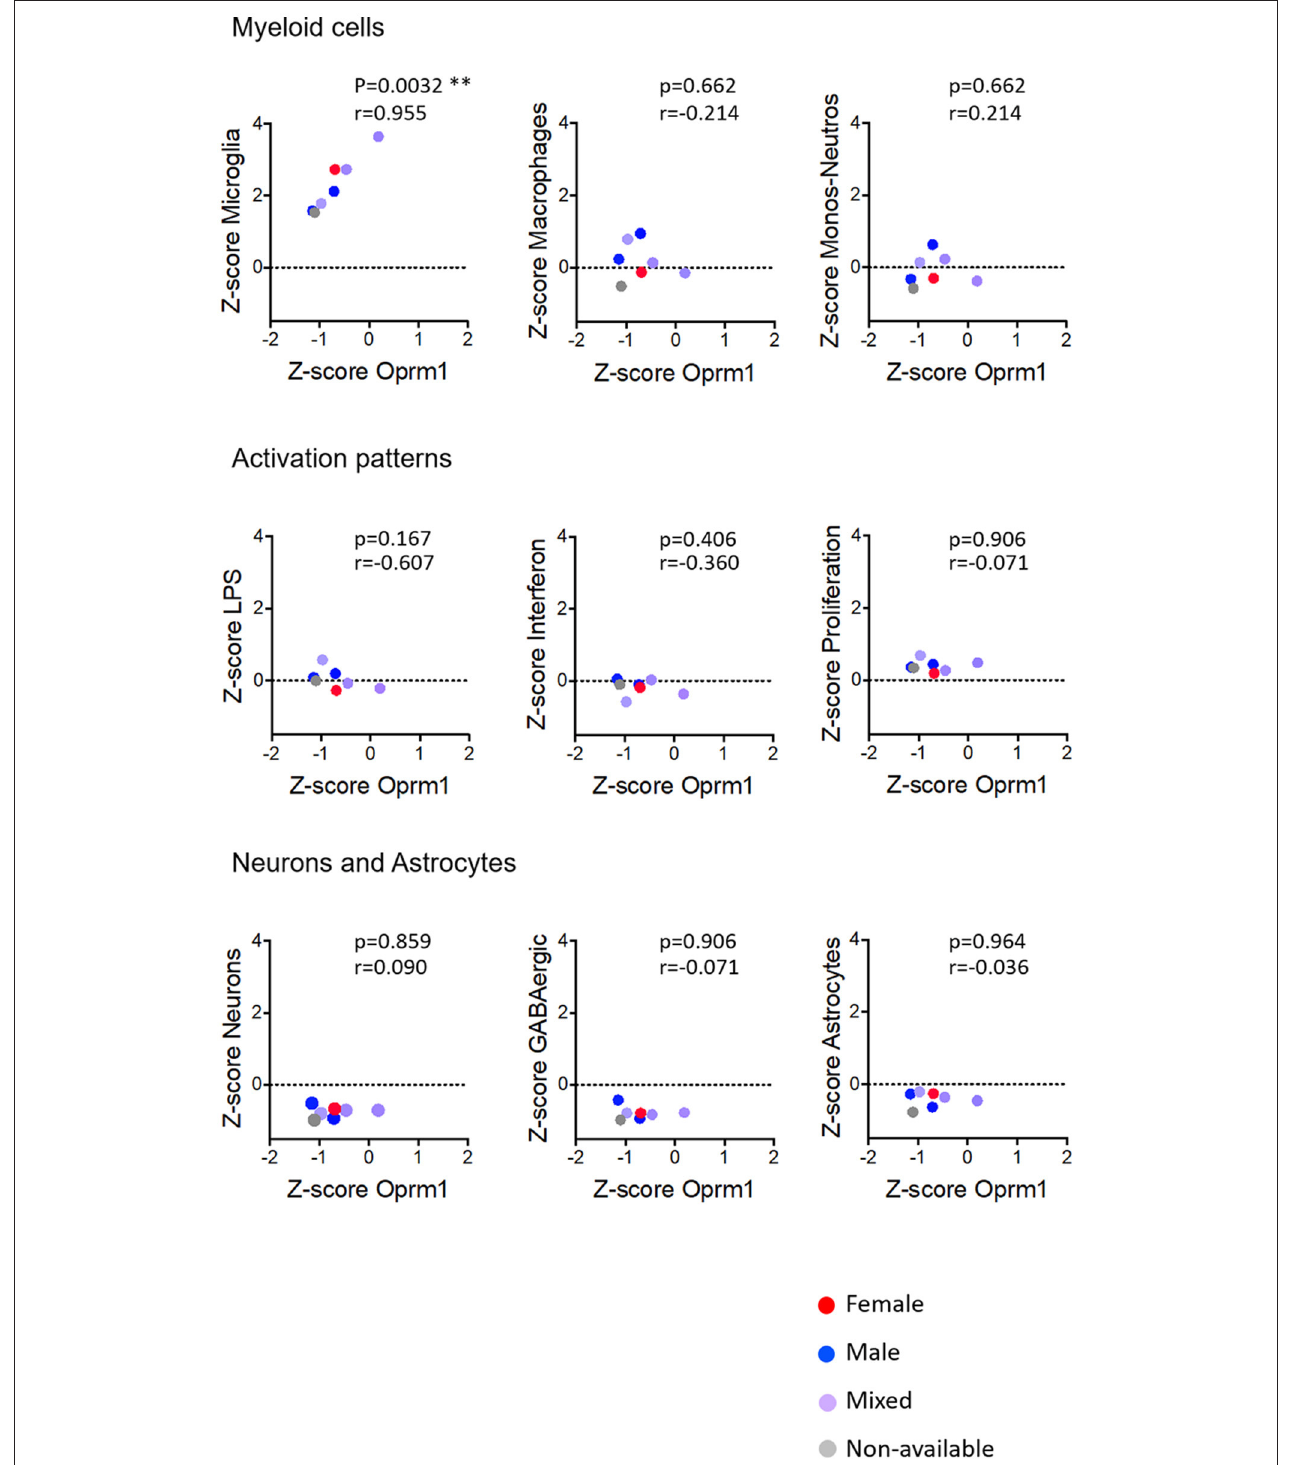
FIGURE 6 | Correlation of Oprm1 gene expression within the Myeloid cells, Activation patterns, and Neurons and Astrocytes gene clusters in mouse cortex datasets. Oprm1 expression is positively and significantly correlated with the microglia-related genes ( r = 0.955; ** p = 0.0032) but does not correlate with the Macrophages- and Monocyte-Neutrophils-related genes ( r ≤ 0.214 ; p > 0.05, ns). Oprm1 expression does not correlate with any of the Activation patterns- ( r < 0 ; p > 0.05, ns), Neurons or Astrocytes gene clusters ( r ≤ 0.09 ; p > 0.05, ns). All correlations were determined with the Spearman’s correlation test.